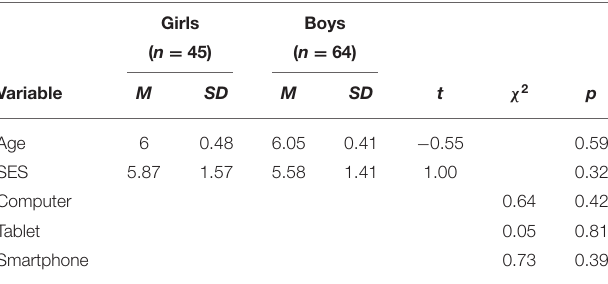
TABLE 1 | Gender differences in age, SES (means, standard deviations, and t -test), and use of digital devices (Chi-square